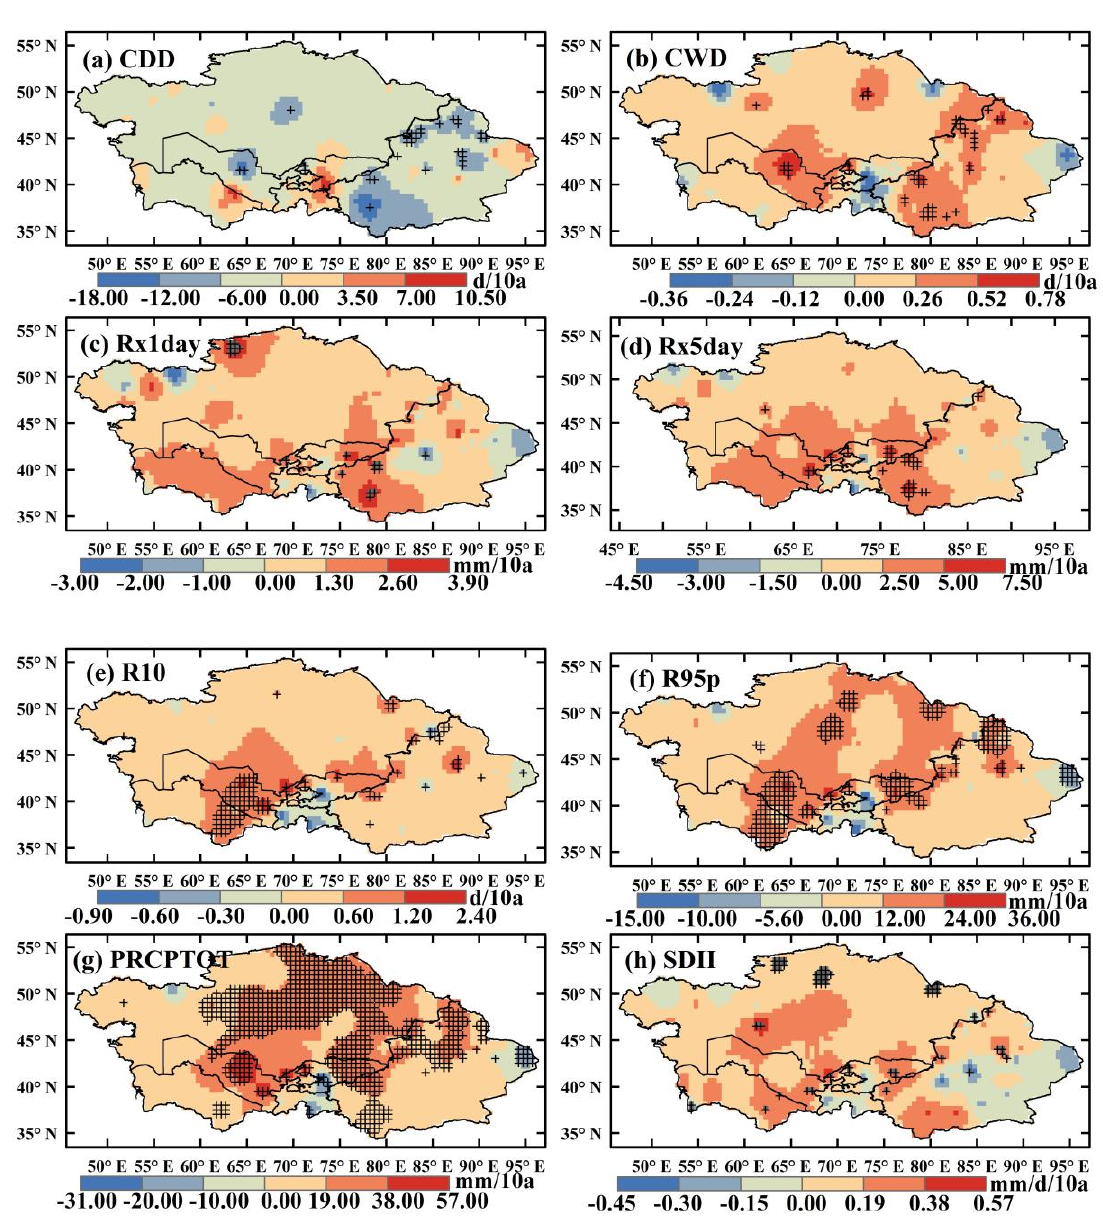
Figure 5. Geographical patterns of linear trends of annual extreme indices series obtained from CPC during 1982–2020 in CA, where the cross symbols denote significance at the 0.05 level: ( a ) CDDs; ( b ) CWDs; ( c ) Rx1day; ( d ) Rx5day; ( e ) R10; ( f ) R95P; ( g ) PRCPTOT; ( h ) SDII.